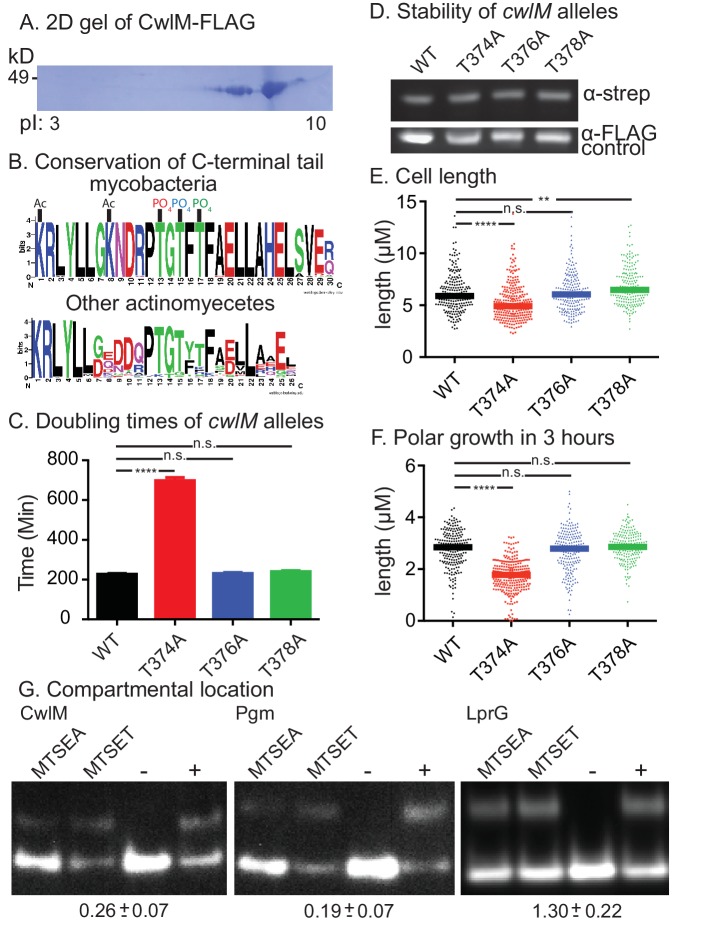
CwlM is phosphorylated and cytoplasmic.(A) 2-D gel of CwlM-FLAG from Msmeg (CB100) with the isoelectric point (pI) indicated on the bottom. (B) Weblogo diagrams of the C-terminus of CwlM homologues. Acetylation (Ac) and phosphorylation (PO4) sites are indicated. The colors of the three phosphates match the colors of the corresponding phospho-ablative strains in C, E and F. (C) Doubling times of L5::cwlM-FLAG WT (CB300) and phospho-ablative mutants (T374A = CB300; T376A = CB345; T378A = CB348). All multiple comparisons throughout were performed by One-way ANOVA with a Dunnett multiplicity correction. The adjusted p values for each mutant compared to WT are: T374A =< 0.0001; T376A = 0.88; T378A = 0.15. (D) α-strep western blot of L5::cwlM-strep WT (CB663) and phospho-ablative mutants (CB666, 669, 672). A background band on the same blot probed with α-FLAG is used as a control. Westerns of the L5::cwlM-FLAG strains could not be used because of high background. (E) Cell length of 200–300 cells from L5::cwlM-FLAG WT and phospho-ablative mutants. The adjusted p values for each mutant compared to WT are: T374A =< 0.0001; T376A = 0.99; T378A = 0.01. (F) Length of the longer unstained pole of cells in (E). Cells were stained with ARD and grown for three hours before imaging. The adjusted p values for each mutant compared to WT are: T374A =< 0.0001; T376A = 0.59; T378A = 0.36. (G) Substituted cysteine accessibility. α-strep western of cells with strep-tagged Pgm (CB886, MSMEG_4579, cytoplasmic control), lprG (CB706, Rv1411, periplasmic control) and CwlM1cys (CB457) that were cysteine-blocked with MTSEA (membrane permeable) or MTSET (membrane impermeable) then alkylated at unblocked cysteines. Control samples: (−) = not alkylated or blocked, (+) = alkylated but not blocked. % alkylation (%alk.) = high band/ total for each sample. The periplasmic localization score = (%alk.MTSEA/% alk.MTSET) and is indicated below the gel for each protein ± the 95% confidence interval from two biological replicates. Scores < 0.5 are cytoplasmic, near 1 are periplasmic.